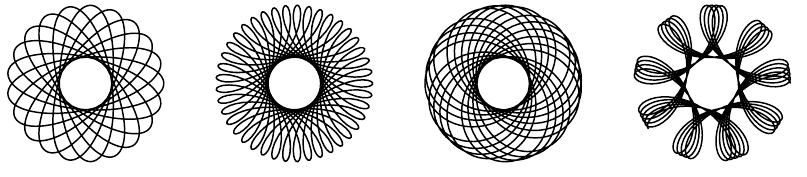
Figure 1. Trochoidal-like